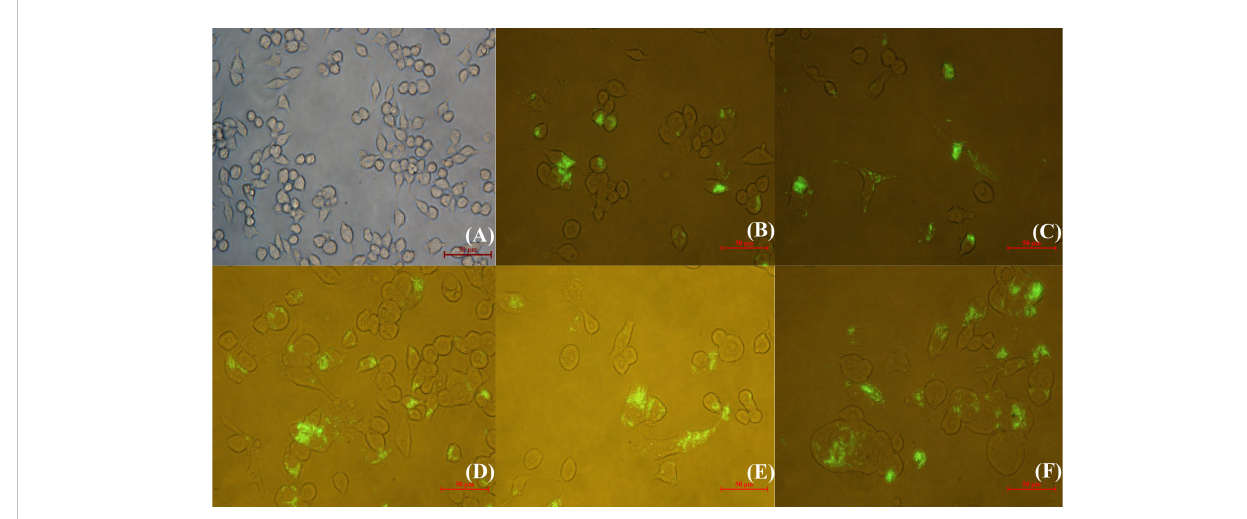
FIGURE 1 Inverted fl uorescence microscopic observation of RAW264.7 infected with GFP- N. seriolae. (A) uninfected cells; (B) 2 hpi; (C) 4 hpi; (D) 6 hpi; (E) 8 hpi; (F) 12